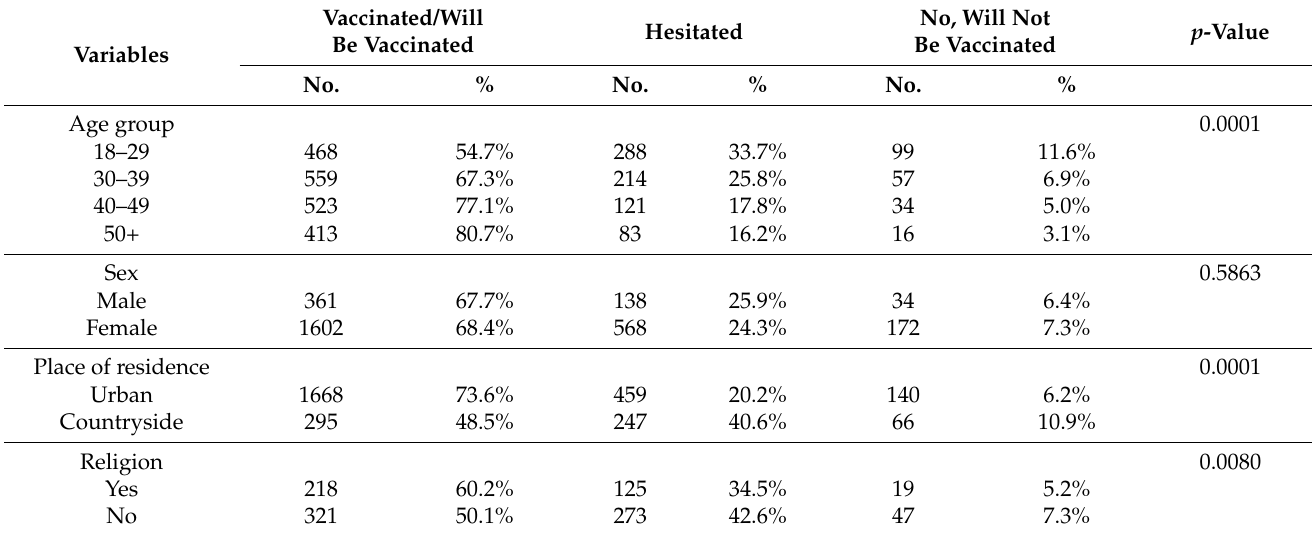
Table 1. Willingness to be vaccinated for COVID-19 by demographics.